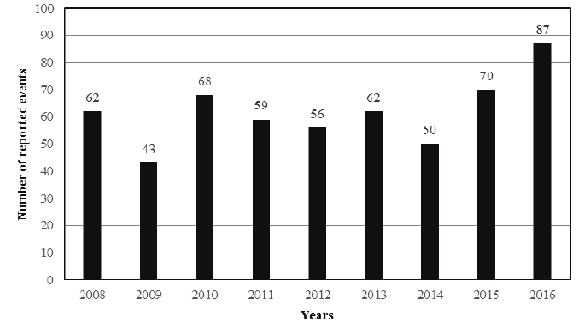
Fig. 1. Number of reported aviation events caused by powerplants installed on Polish registered